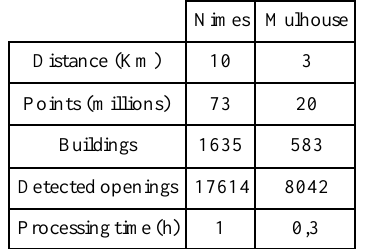
Table 4: Nimes and Mulhouse datasets and